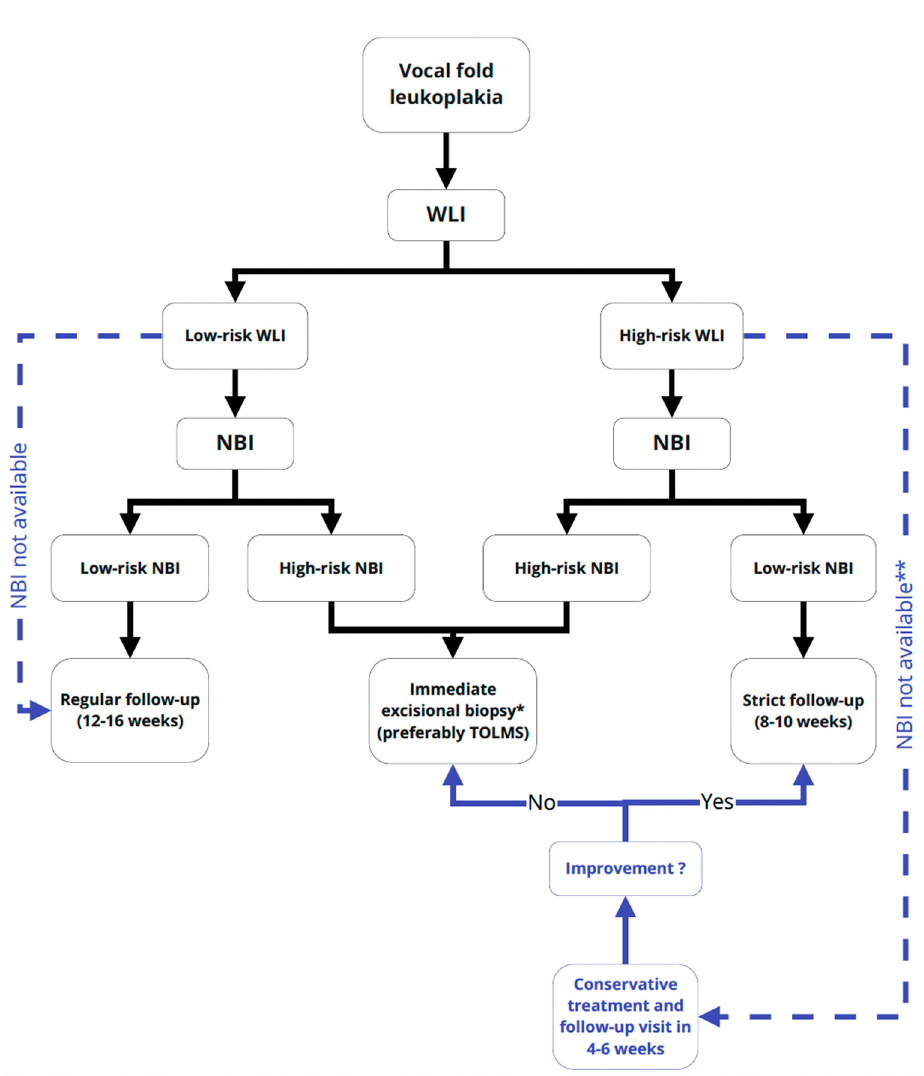
Figure 2. Flowchart representing the management algorithm using the three-tier classification in WLI and Ni 2019 classification in NBI in predicting high- and low-risk leukoplakia. Low-risk WLI: type 1 and 2 and high-risk WLI: type 3 acc. to Chen 2019 classification; low-risk NBI: type 1, 2, 3, 4 and high-risk WLI: type 5 and 6 acc. to Ni 2019 classification. Abbreviations used: VFL—vocal fold leukoplakia; WLI—white light imaging; NBI—Narrow Band Imaging; CT—conservative treatment; TOLMS—Transoral Laser Microsurgery; * under general anesthesia; ** referral to external NBI